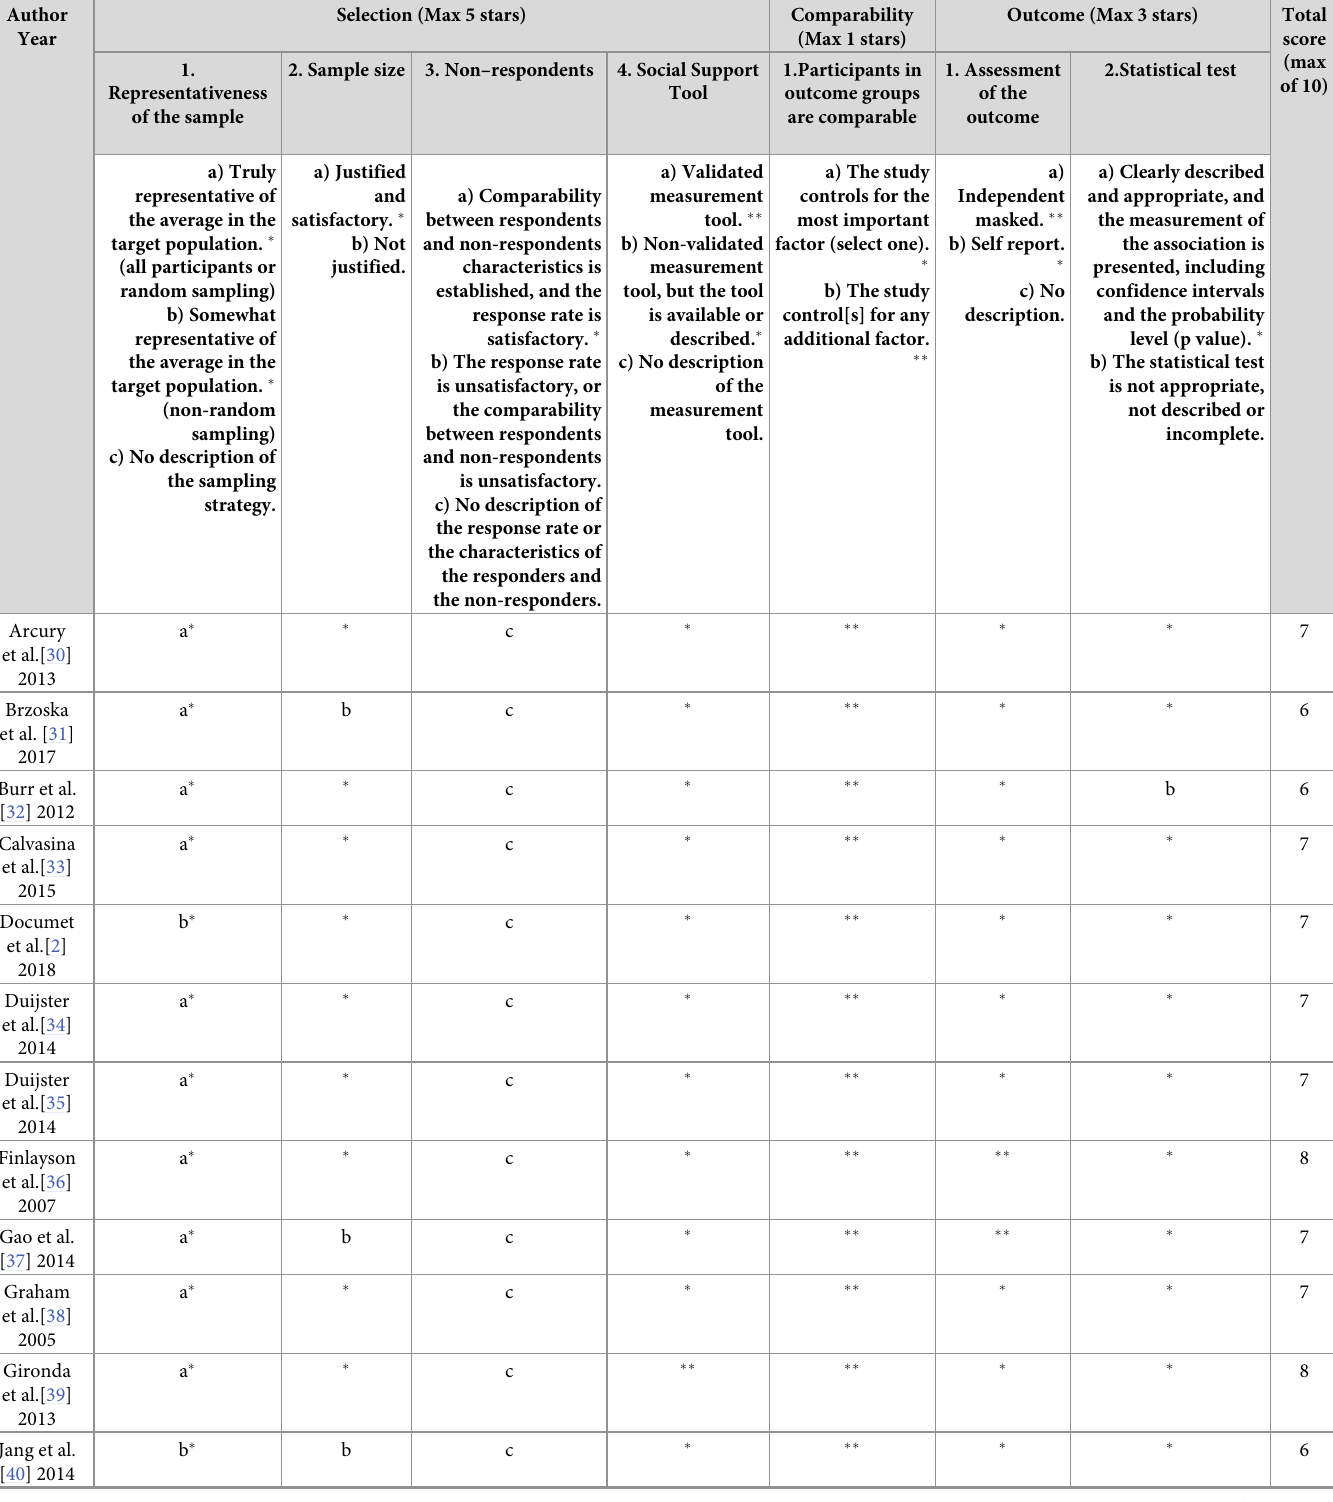
Table 3. Critical appraisal for quantitative